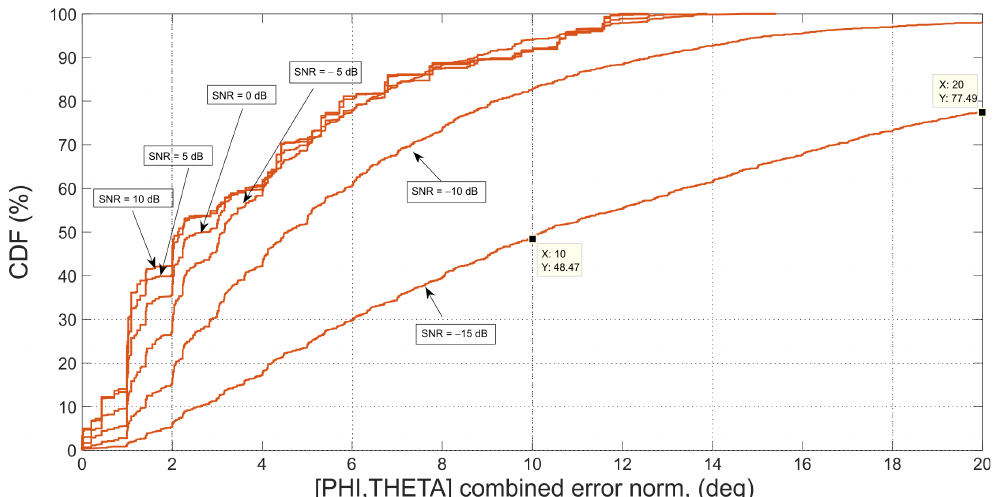
Figure 16. Simulated cumulative distribution function for combined 2-D DoA as a function of signal to noise